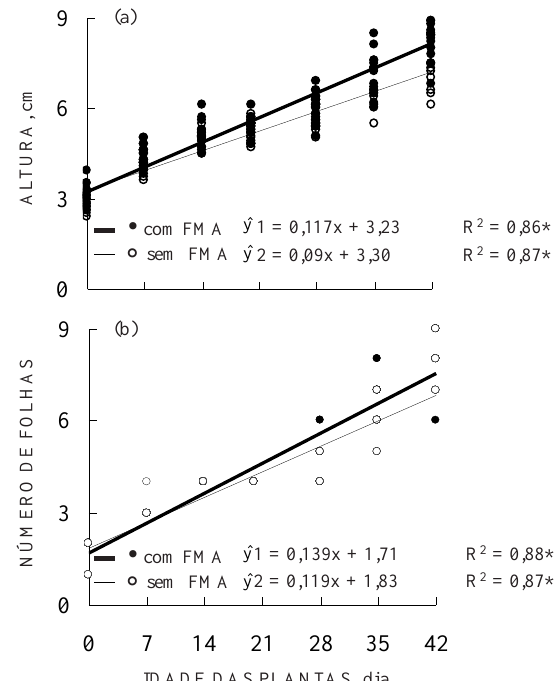
Figura 1. Altura média (a) e número médio de folhas de plantas de mamoeiro (b), inoculadas ou não com Glomus macrocarpum , considerando a idade das plantas, fase de bandeja. Média de dezesseis repetições. (* significativo a 5